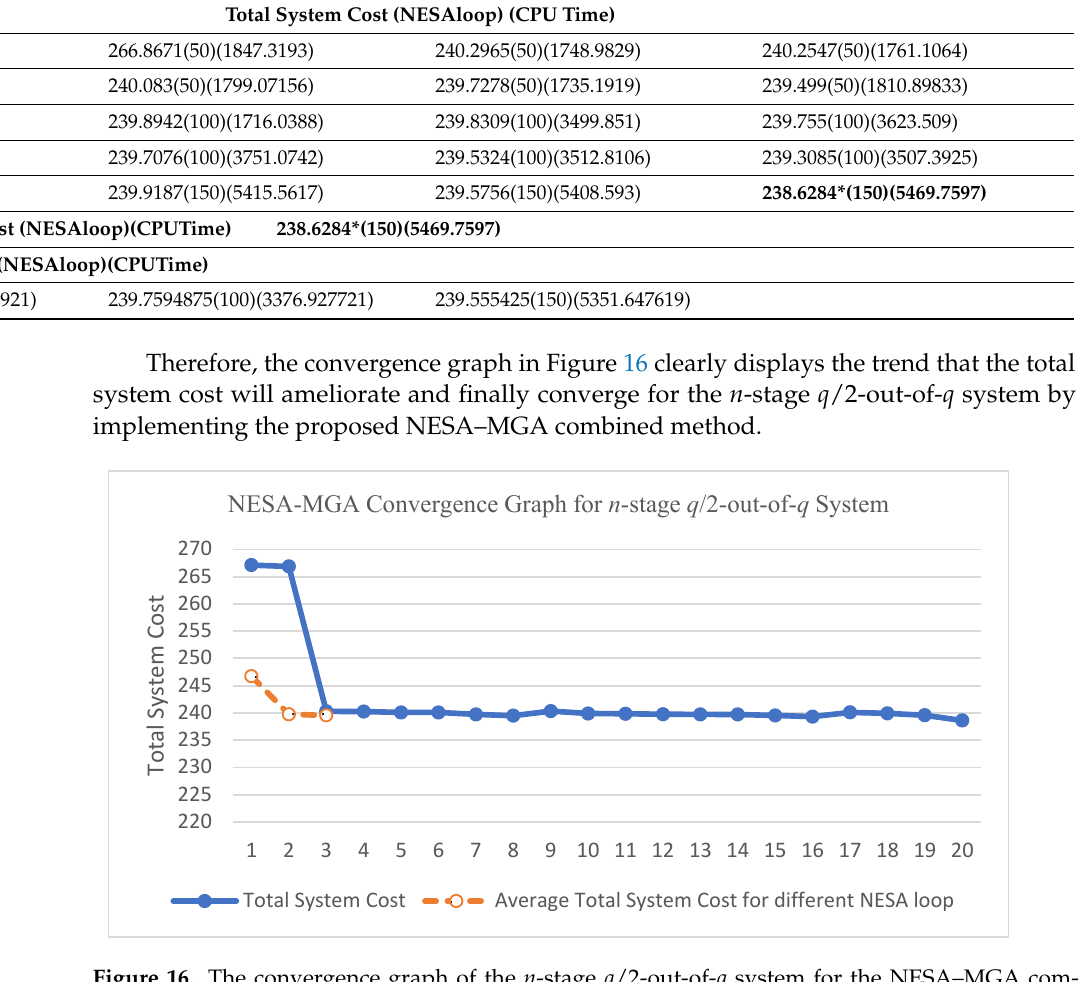
Table 32. Optimal Solutions obtained by NESA–MGA for the for the n -stage q /2-out-of- q system. SAloop = 150 cr-rate = 0.95 mu-rate = 0.5 GApopulation = 200 GAloop = 200